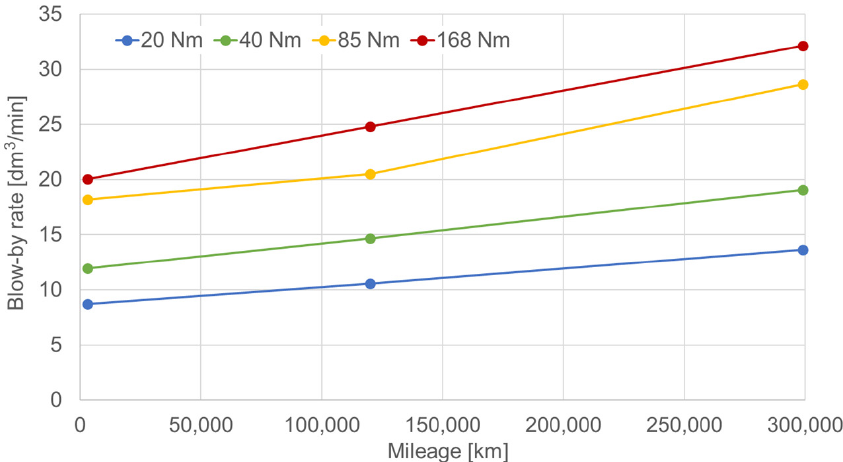
Figure 7. Effect of wear on blow-by rate at different engine loads.